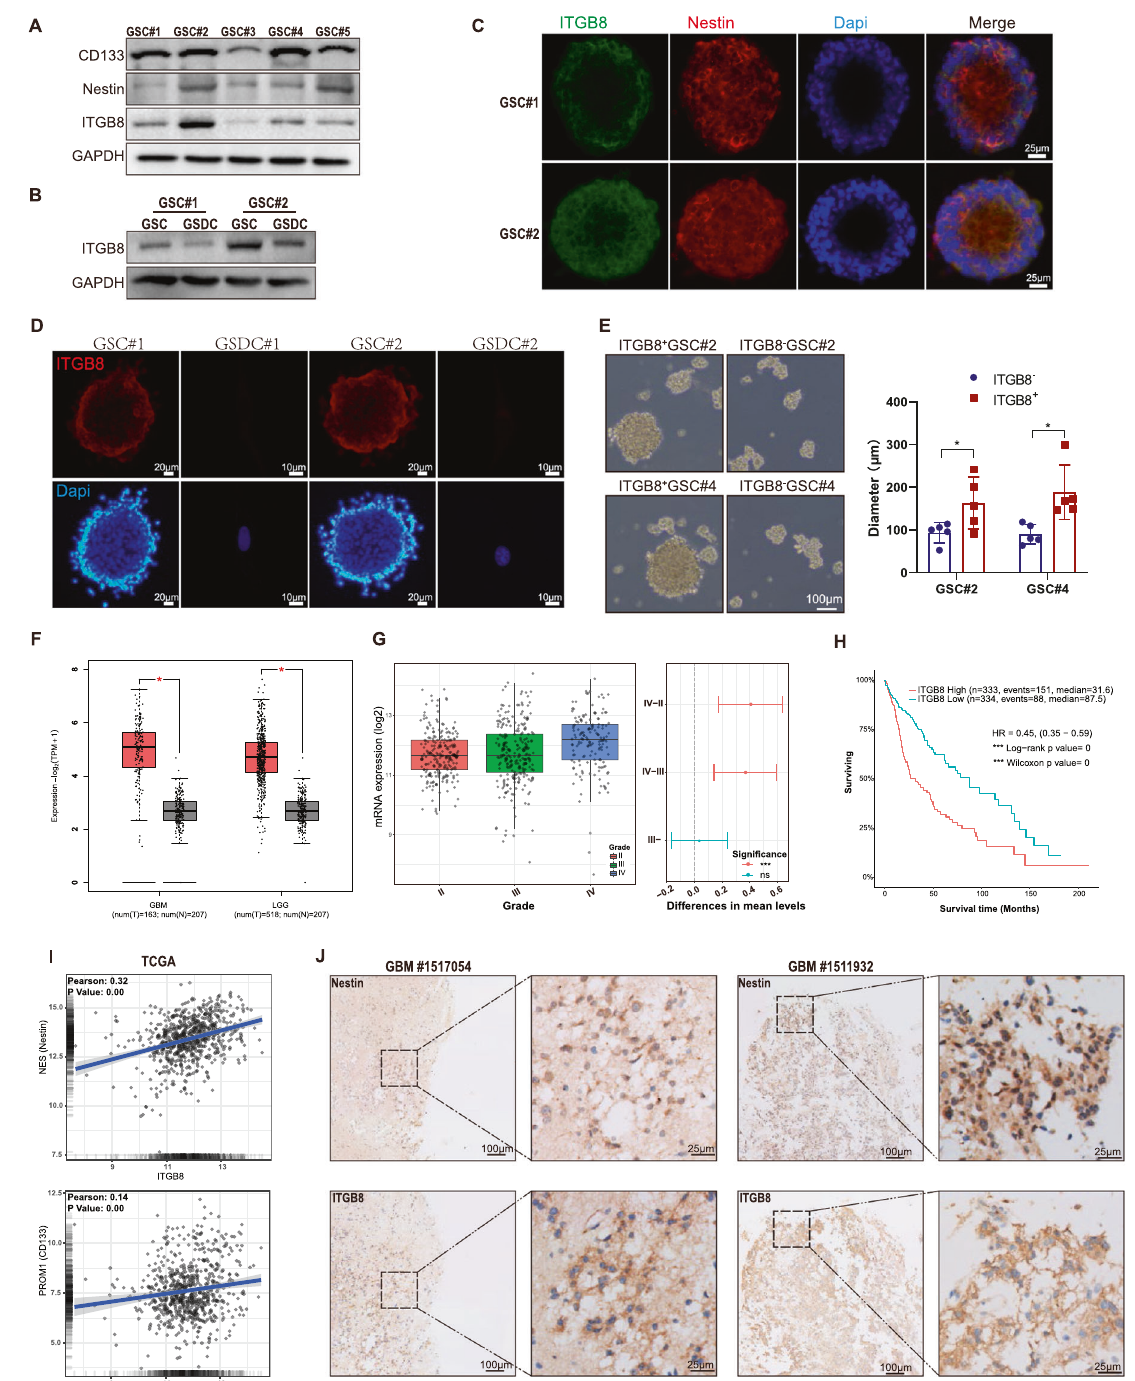
Fig. 1 β 8 integrin is enriched in GBM stem cells. A Levels of indicated proteins in fi ve GBM stem cells derived from human GBM samples were determined via immunoblotting. B Protein levels of ITGB8 in GSCs and corresponding GSDCs were tested via immunoblotting. C Fluorescence staining for ITGB8 and Nestin in GSCs were evaluated. Scale bar = 25 μ m. D Fluorescence staining for ITGB8 in GSCs and GSDCs were measured. Scale bar = 10/20 μ m. E GSC#2 and GSC#4 fractionated into β 8 − and β 8 + cells, were cultured in serum-free medium to form fl oating spheres. Measurement of diameters was conducted in fi ve randomly chosen neurospheres in each group. Scale bar = 100 μ m. F Gene expression analysis of ITGB8 in GBM, LGG (TCGA) and normal brain tissues (GTEx) was conducted via GEPIA2 web tool. G Gene expression of ITGB8 in TCGA glioma dataset was analyzed based on WHO grade. H Kaplan – Meier analysis for overall survival of glioma patients with high or low ITGB8 expression in TCGA glioma datasets. I Correlation between gene expression of ITGB8 and stem cell markers in TCGA glioma dataset was evaluated. J Representative IHC images of Nestin and ITGB8 in human GBM tissues. Scale bar = 25/100 μ m. Uncropped western blot images are shown in Supplementary Fig. 5. Data are expressed as mean ± SD.** p < 0.01, *** p < 0.001. IHC Immunohistochemistry.